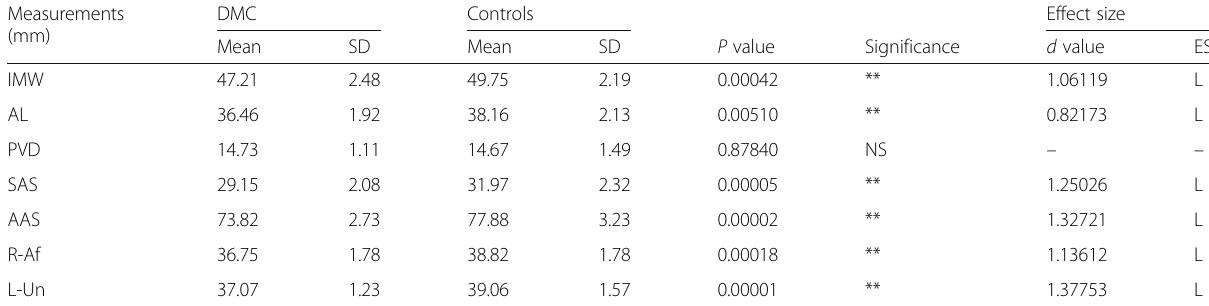
Table 2 Results of statistical comparisons between the groups Measurements DMC Controls (mm)